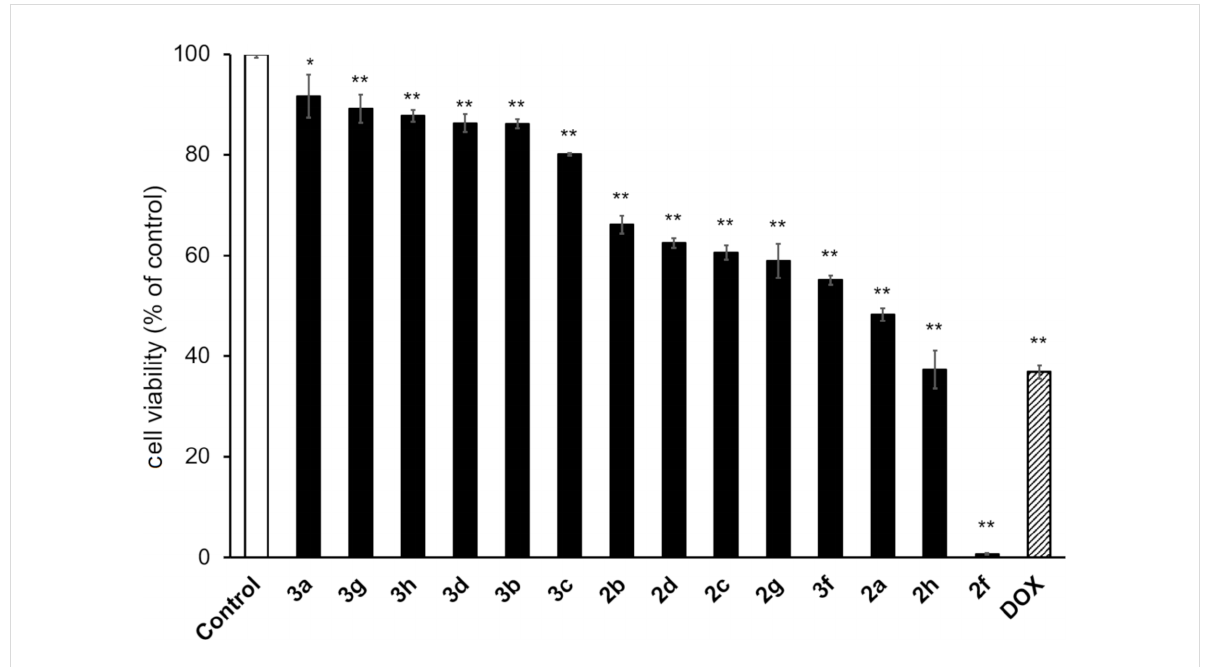
Figure 5: The cytotoxic effect of the bis(2-arylimidazo[1,2- a ]pyridin-3-yl) diselenides 2 and selenides 3 on human cervical cancer HeLa cells. HeLa cells were exposed with or without each compound at 25 µM for 24 h. The cell viability of HeLa cells was confirmed by MTT assays. The data are represented as mean ± S.D. values of four samples. * p < 0.05; ** p < 0.01 compared to the control. DOX: doxorubicin.